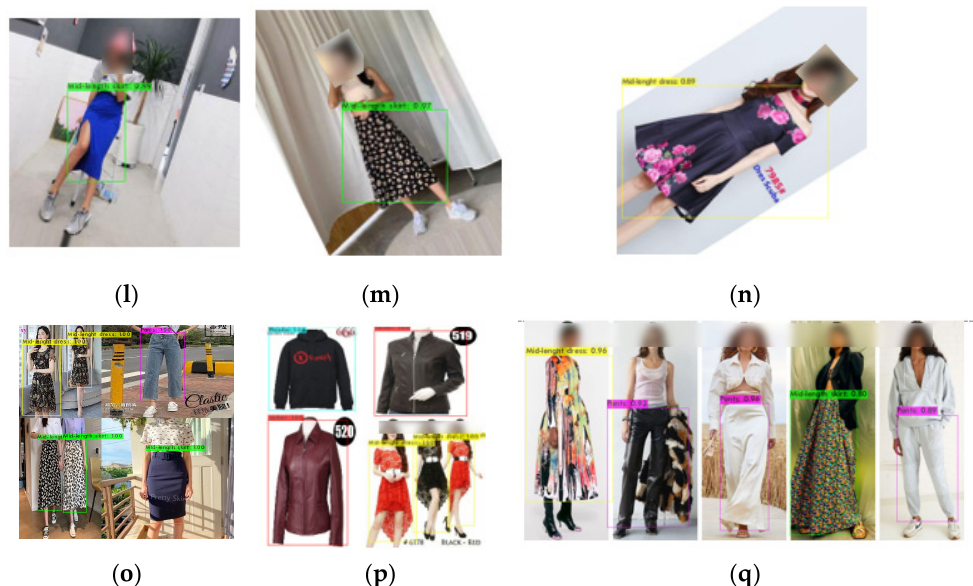
Figure 17. Detection results of our proposed FC-YOLOv4. ( a – d ) FC-YOLOv4 Overlaping Detec- tion; ( e – g ) High Brightness Overlaping Detection; ( h – k ) Cluttered Background Detection; ( l – n ) Rotated Images Detection; ( o – q ) Multiple Categories Detection.